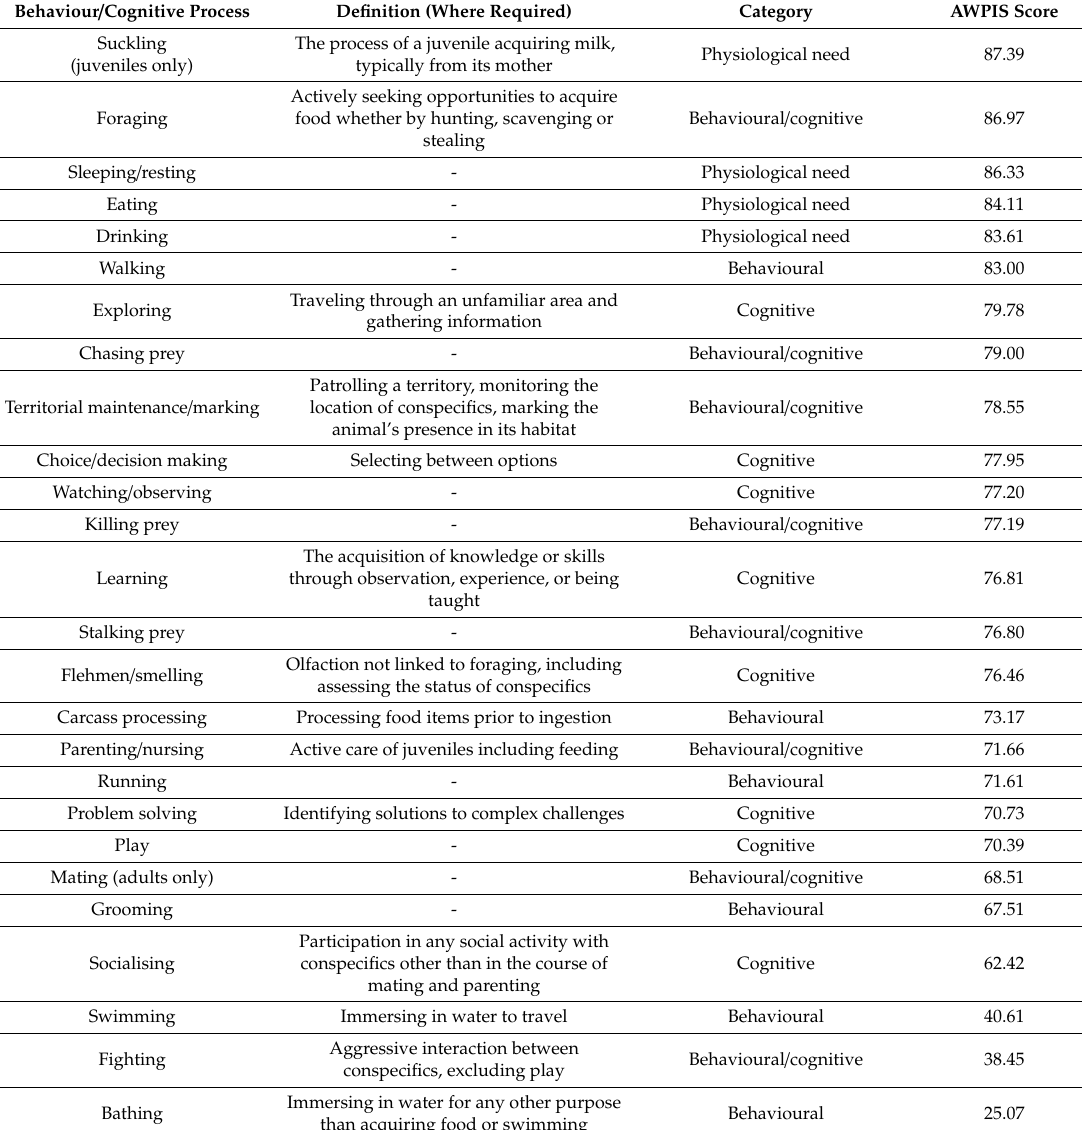
Table 1. Animal Welfare Priority Identification System (AWPIS © ) rankings for Amur